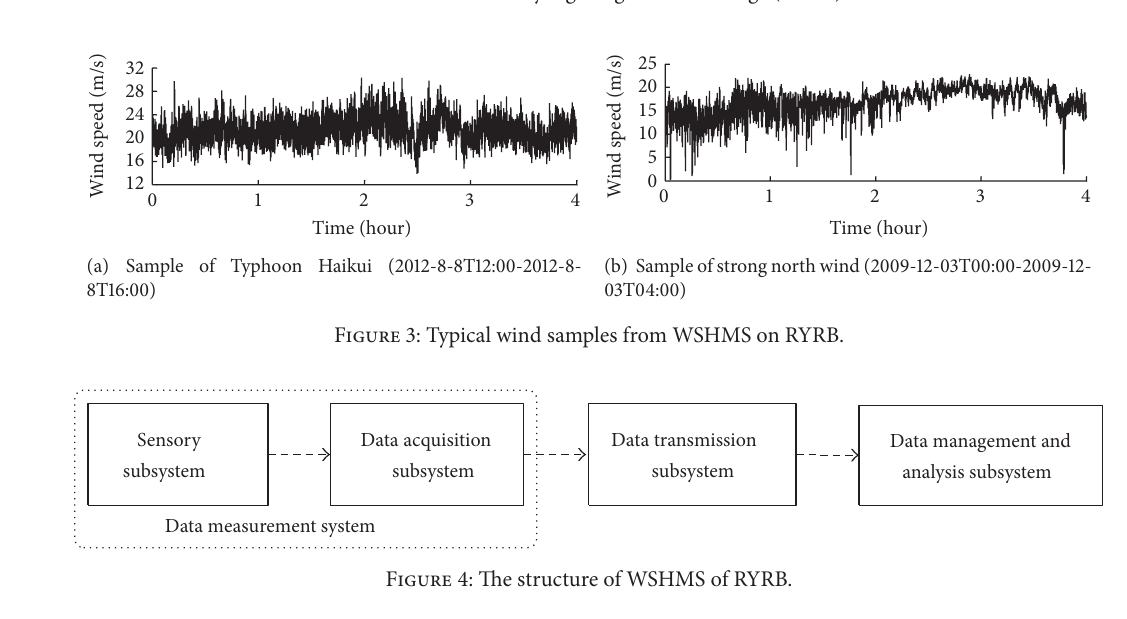
Figure 2: View of Runyang Yangtze River Bridge (RYRB).